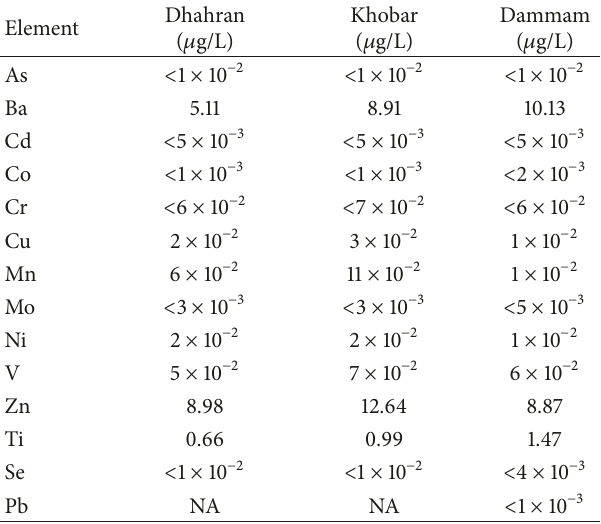
significant percentage in both EDX and XRF analysis. Results Table 3: Trace metal levels in PM samples collected from Dhahran, Khobar, and